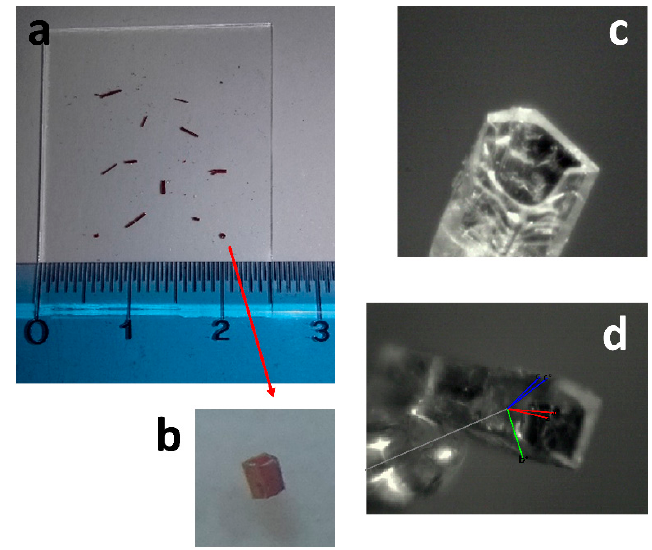
Figure 4. ( a ) Single rectangular cross-shaped tubular crystals of C1 on a glass slide; ( b ) magnification 4 × of one crystal; ( c ) view of the crystal mounted on the KappaCCD diffractometer (Bruker-Nonius B.V., The Netherlands) using the KappaCCD video microscope (Bruker-Nonius B.V., The Netherlands); ( d ) unit cell axis are reported on the crystal: a or a* in red, b or b* in green, c or c* in blue.